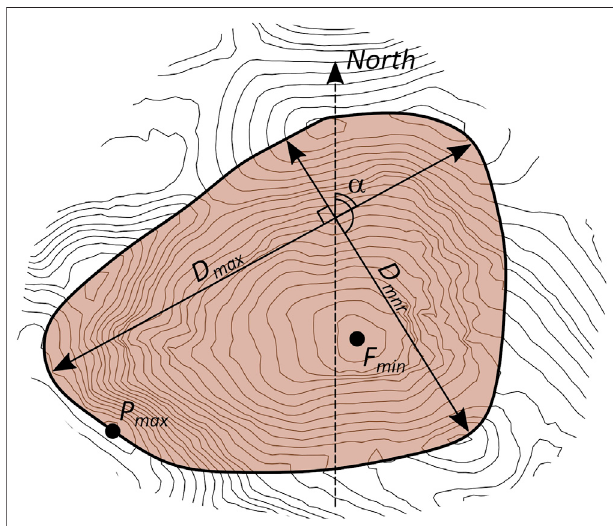
FIGURE 3 | Schematic representation of main morphometric parameters of